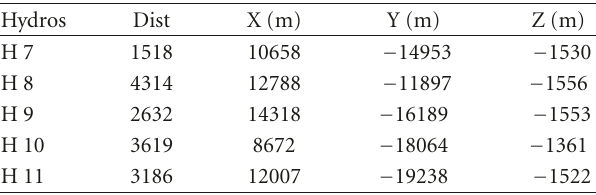
Table 1: Hydrophones positions in dataset 2: Dist = Distance to barycenter